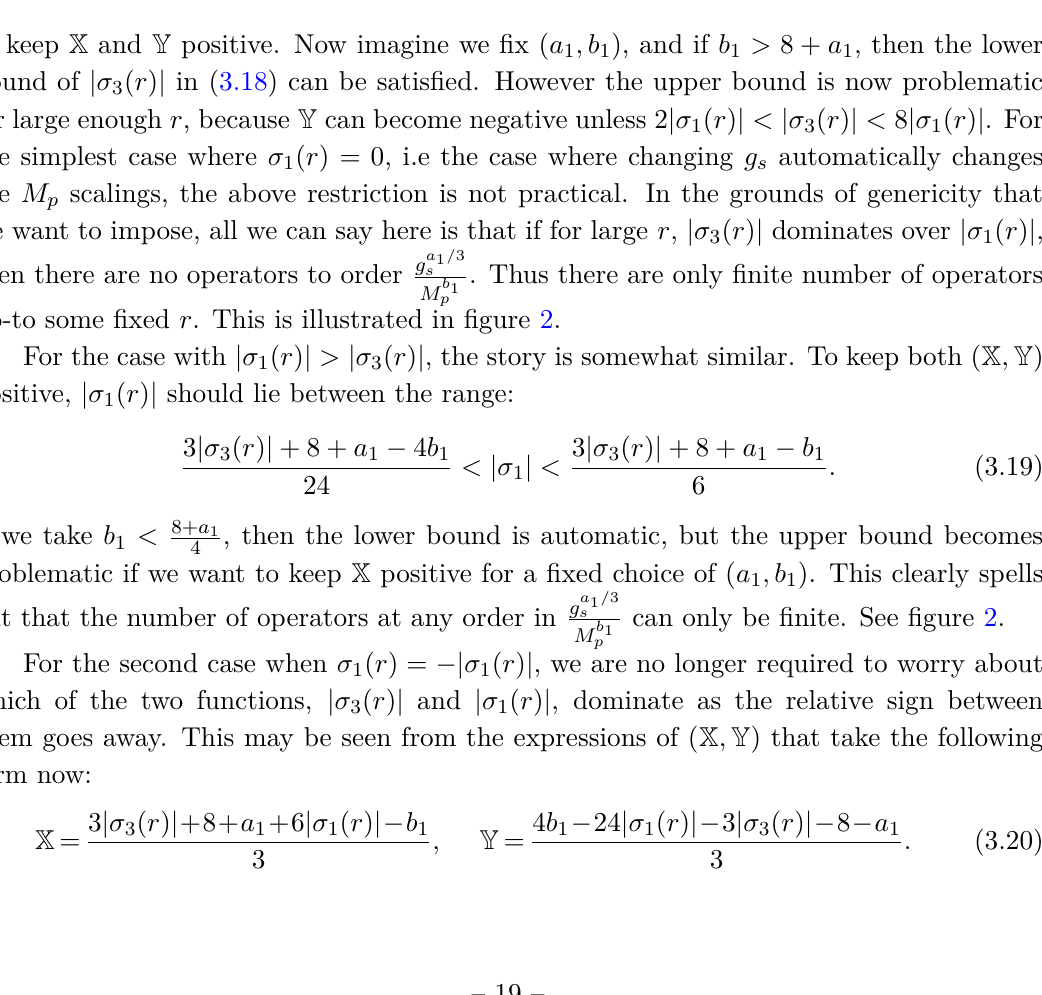
Figure 2 . For σ 3 ( r ) 6 = constant , the number of operators with the same g s scaling can be different for different levels of non-locality. With σ 1 ( r ) > 0 but falling outside of the window (3.18) the number of operators at higher non-locality level proliferate faster, but there are still finitely many for fixed M p